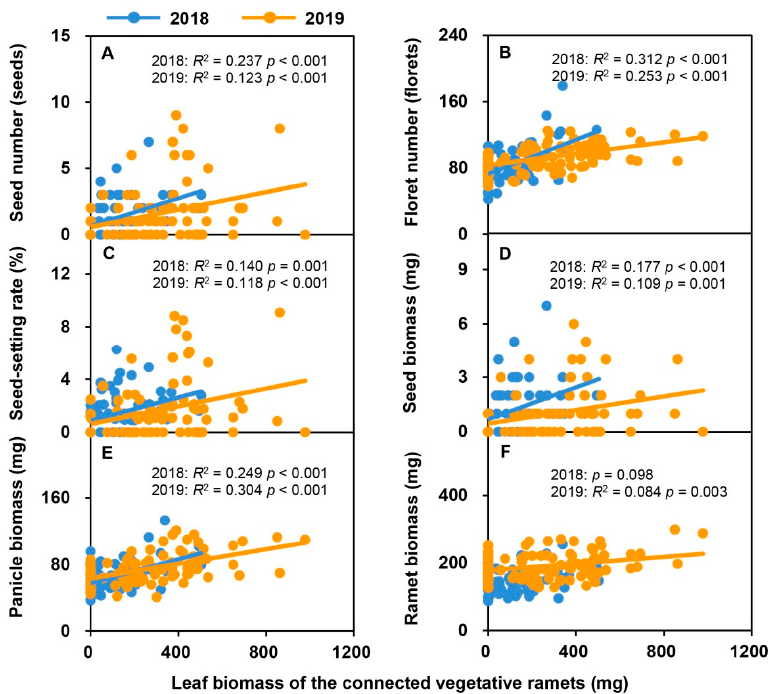
Figure 2. Relationships between sexual reproductive characteristics (seed number, ( A ); floret number, ( B ); seed-setting rate, ( C ); seed biomass, ( D ); panicle biomass, ( E ); ramet biomass, ( F )) and leaf biomass of vegetative ramets connected to tillering nodes in the natural populations of Hierochloe glabra over two consecutive years. The colored lines represent fitting lines in 2018 ( n = 75) and 2019 ( n = 100). Plants 2020 , 9 , x FOR PEER REVIEW